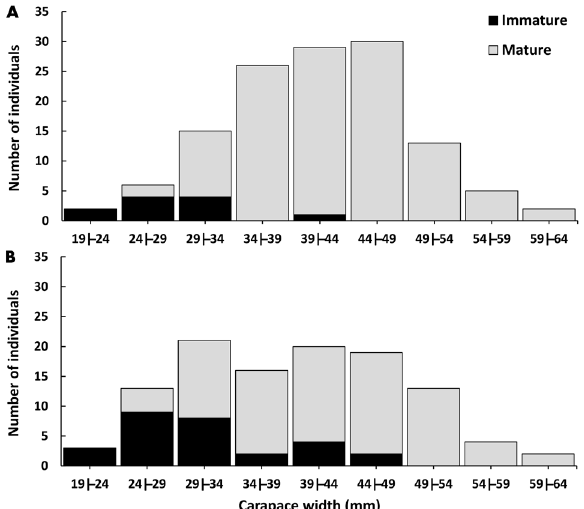
Figure 2. Number of individuals and morphological maturity stages for each carapace width (CW) class for females (A) and males (B) of Hepatus pudibundus off Sergipe (northeastern Brazil) in